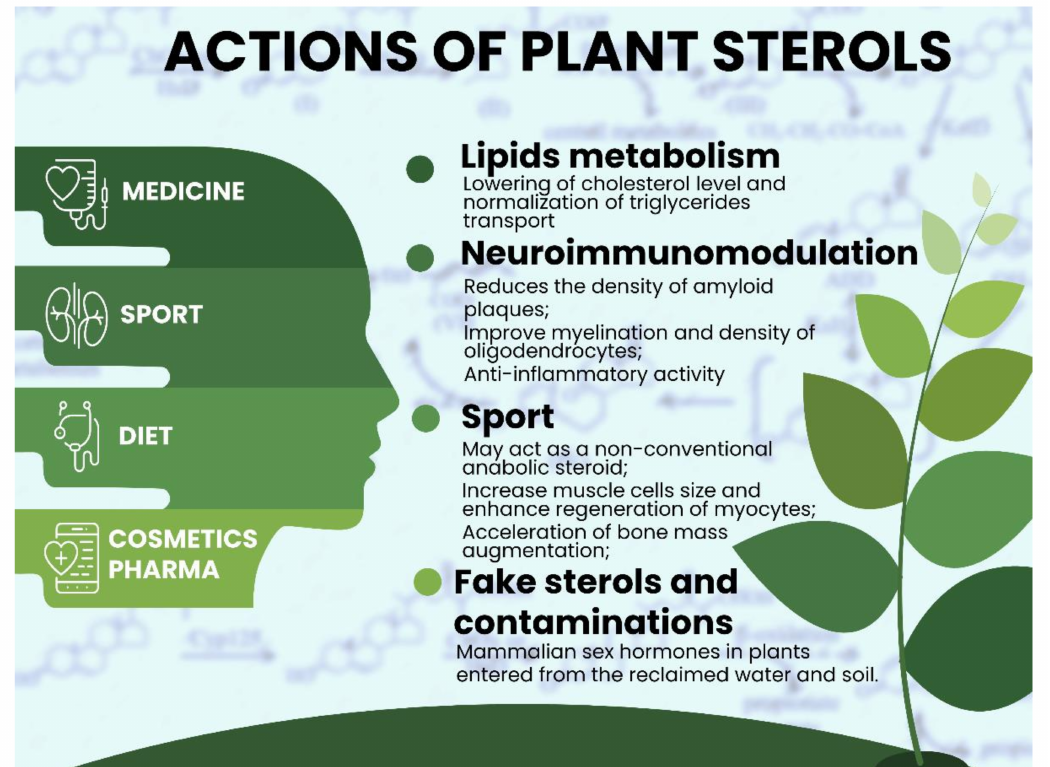
Figure 5. The overall effect of plant sterols and, in particularly, functional food is rather positive. Up to nowadays, sterols are widely used in different ways, but their natural effect (such as implication in lipids metabolism and neuro- and immunomodulation) does merit attention and seems to be vital for reason of their steroid-like properties. Therefore, it is not surprising that sterols are used in cosmetics, pharma and sometimes are considered in professional sport as suspicious substances that may improve human